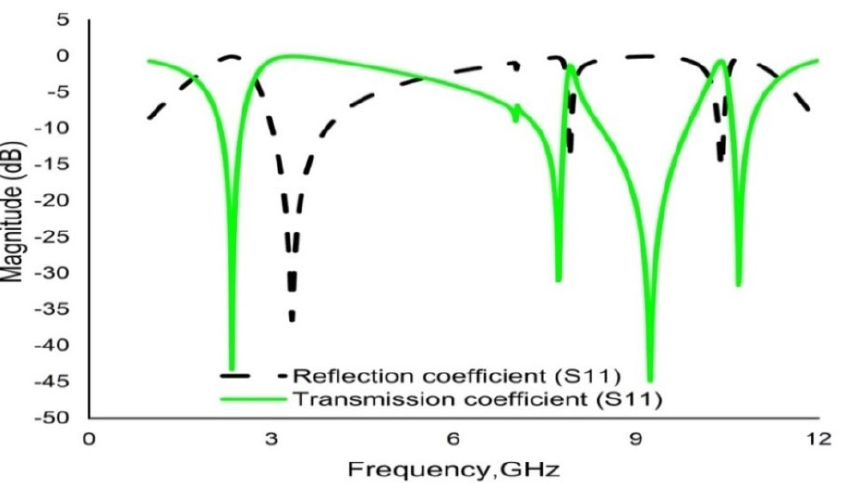
Figure 13. Graph of the S parameters ( 𝑆 (cid:2869)(cid:2869) and 𝑆 (cid:2870)(cid:2869) ) of the unit cell .